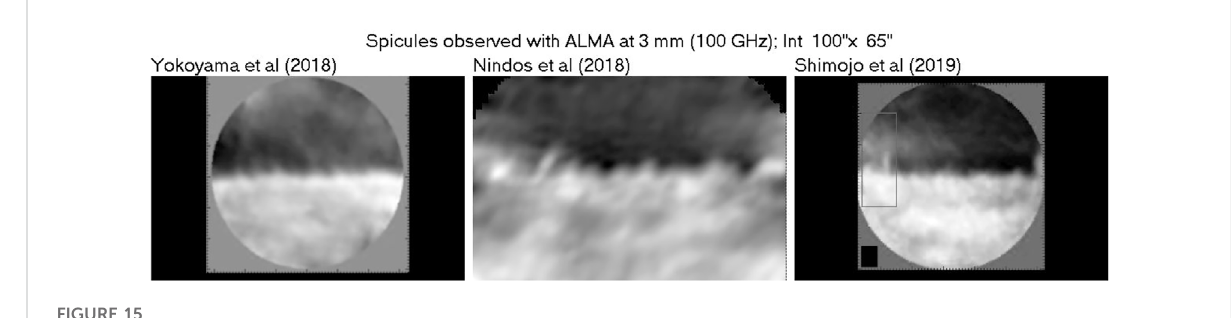
FIGURE 15 The fi rstALMAobservationsofspiculesat100 GHz(3 mm).Imagesreprocessedbytheauthorsforbettervisibility.Reproducedfrom fi gure11of Alissandrakis